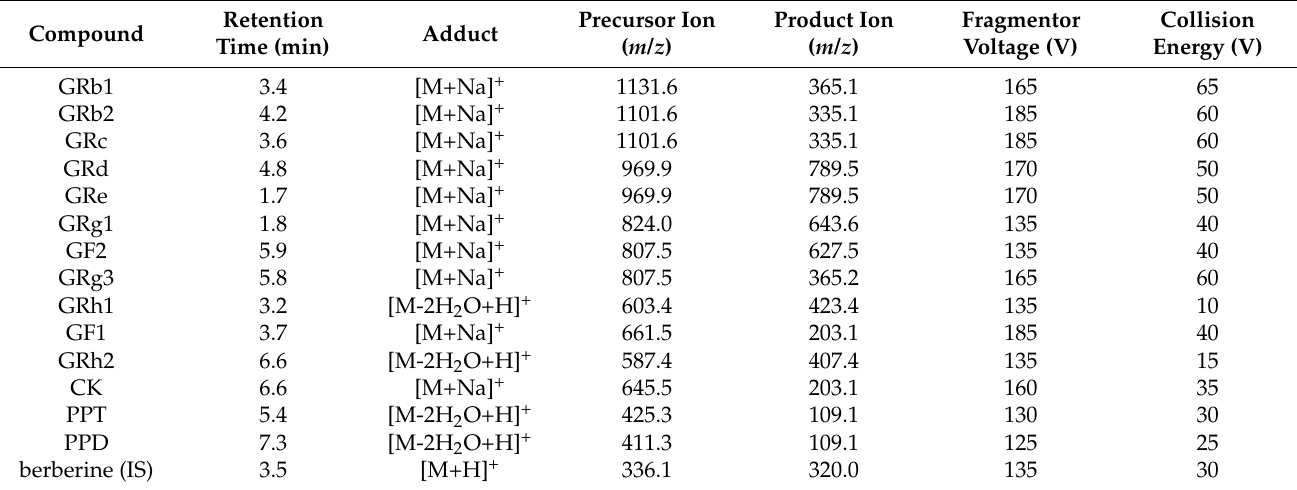
Table 1. Mass spectrometry (MS)/MS parameters for the detection of the ginsenosides and internal standard.